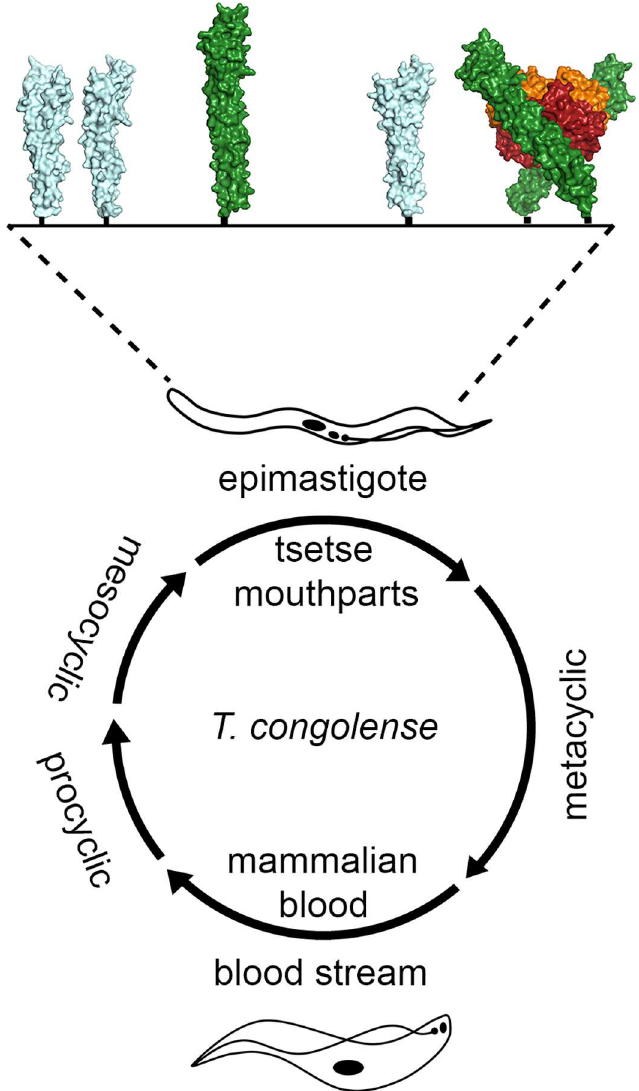
Fig 2. The T . congolense HpHbR is an epimastigote expressedHb receptor. In the life cycle of T . congolense , HpHbRis expressed predominantlyin the epimastigotes that inhabit the mouthparts of the tsetse fly, where it binds to Hb present in the blood meal of the fly. Here the receptor functionsin the context of the major epimastigote surface protein, GARP. In the structure figure TcHpHbRis green, GARP is light blue, and Hb is orangeand